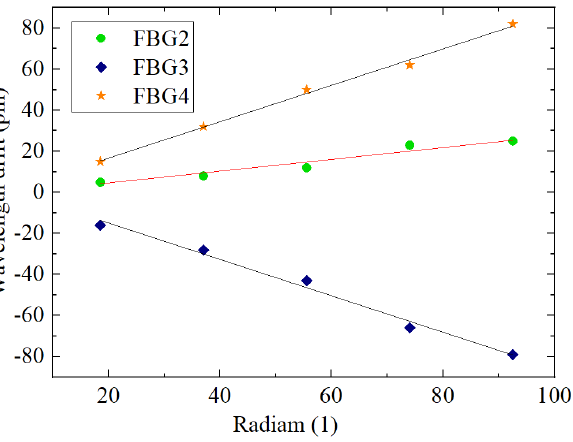
Figure 14. Relationship between radian and FBG wavelength drift of FBG shape sensor.